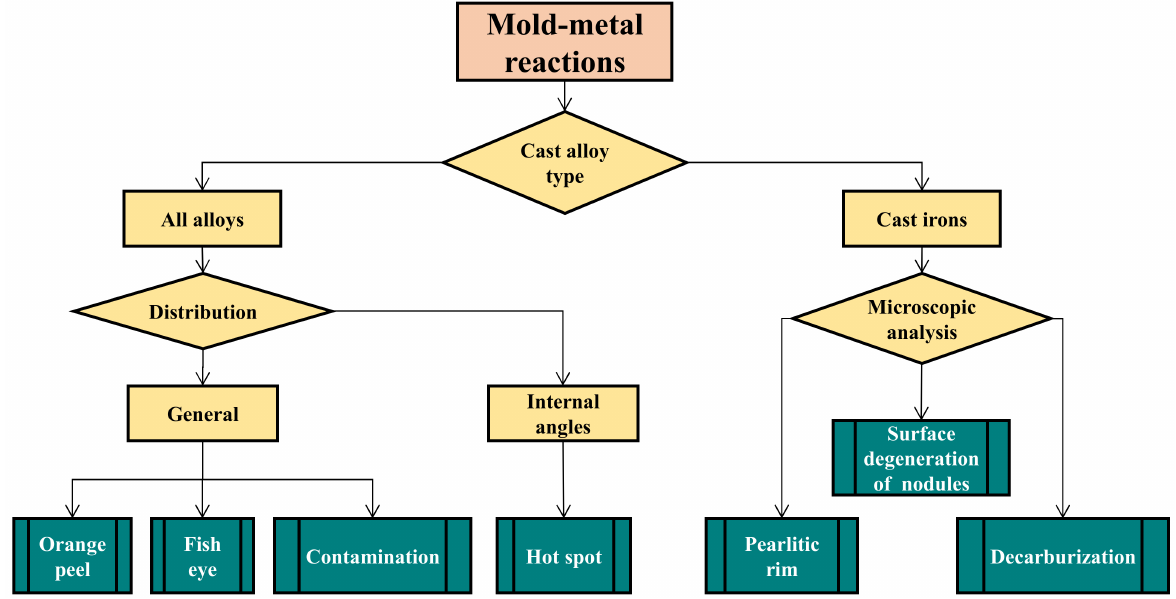
Figure 49. Classification of mold–metal reaction